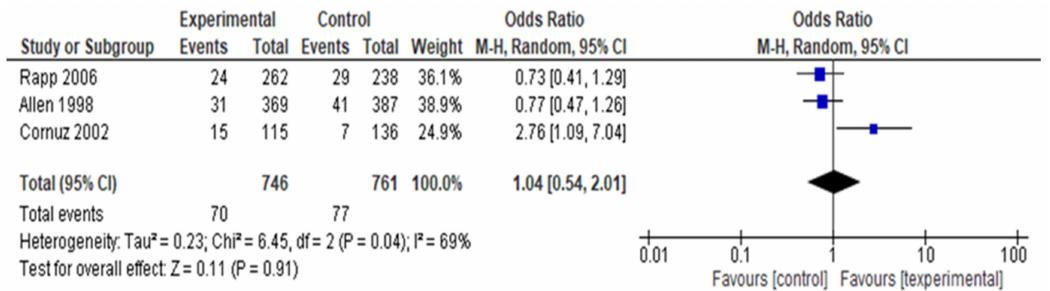
Figure 8. Forest plot for patient smoking cessation at one year after